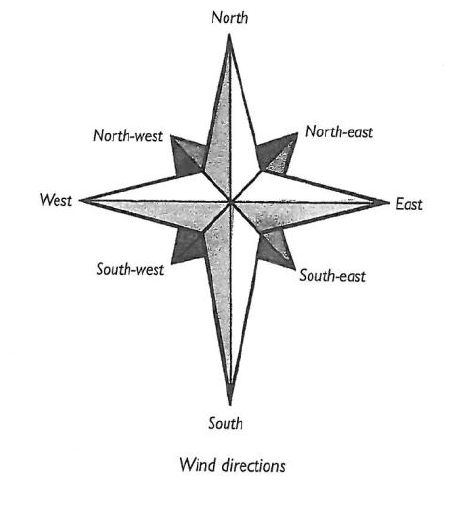
Figure 5: Labelled diagram, but labels do not appear in accompanying text